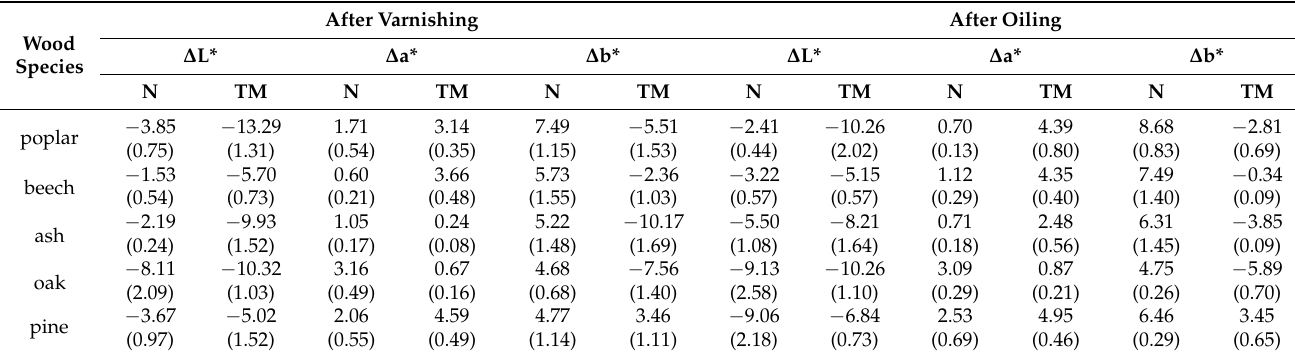
Table 3. Changes of the wood colour parameters (standard deviation in parentheses) after the surface